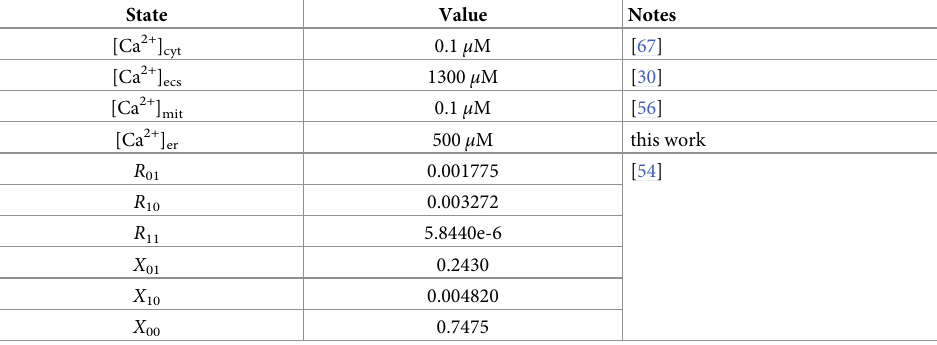
Table 5. Steady state free ionic calcium concentrations enforced in all of our model simulations.